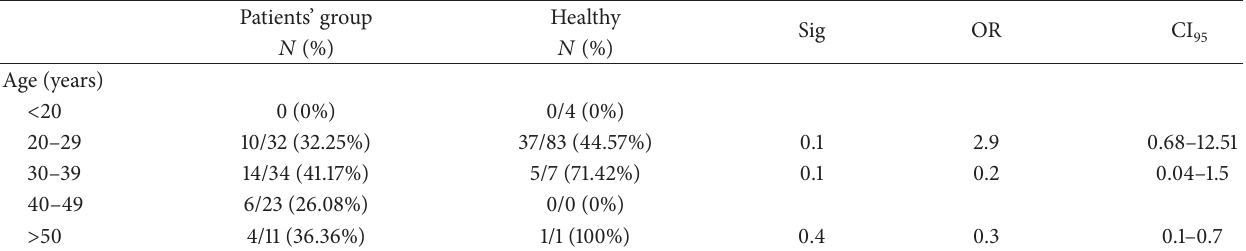
Table 7: The distribution of latent toxoplasmosis according to the age in patients with schizophrenia disorder and healthy controls.